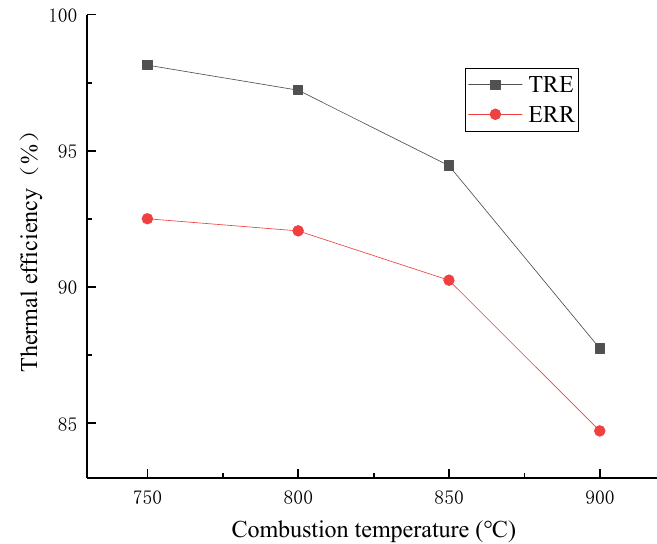
Figure 11. Effect of combustion temperature on heat transfer efficiencies.